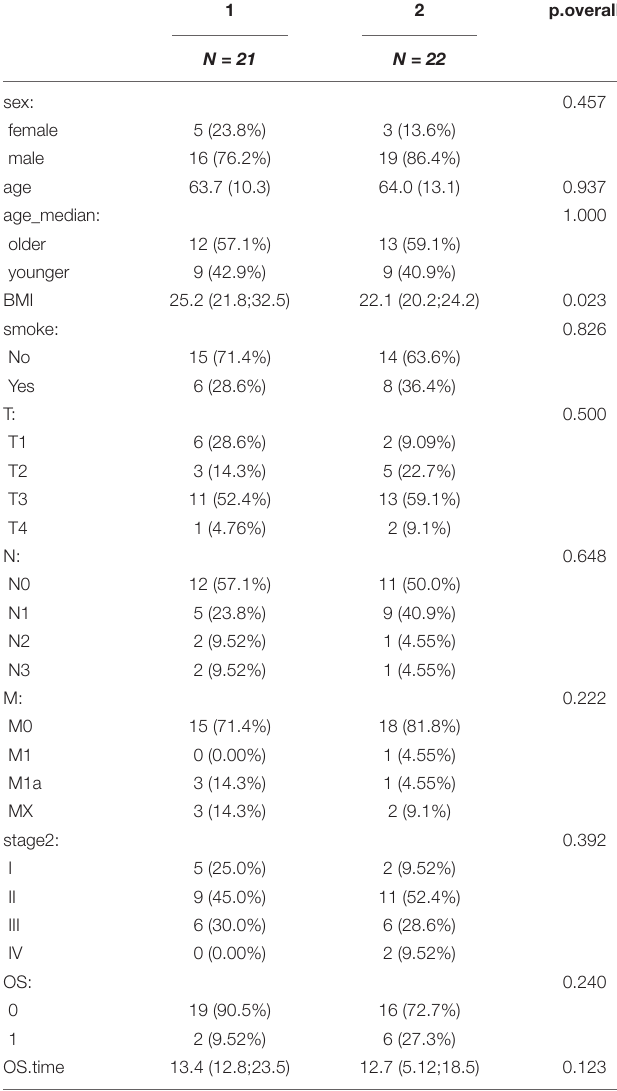
TABLE 1 | Clinical features of the two